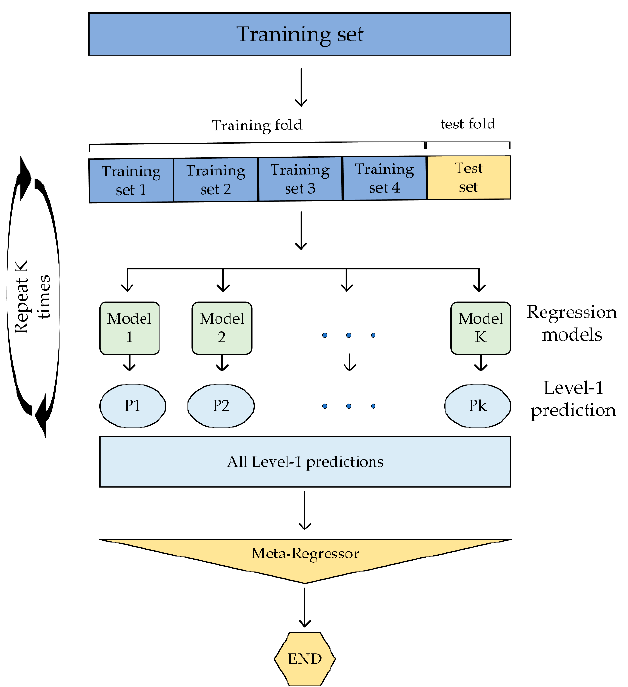
Figure 3. Stacking model structure.